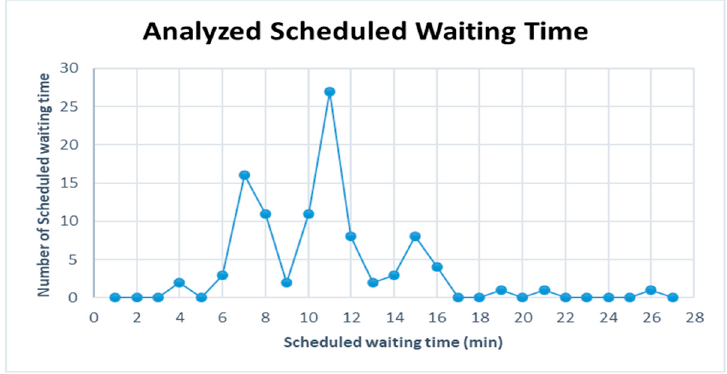
Figure 10. Analyzed Scheduled Waiting Time for Case 2.